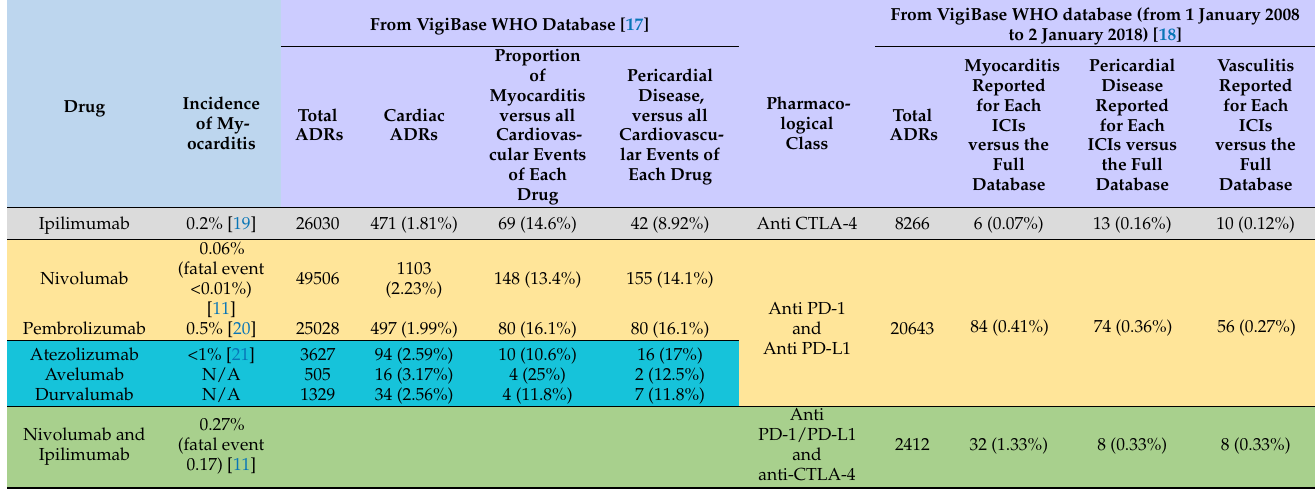
Table 2. Incidence of myocarditis and other cardiotoxic effects for each drug and pharmacological class of ICIs, as reported from clinical trials and within the VigiBase (the World Health Organization global database for